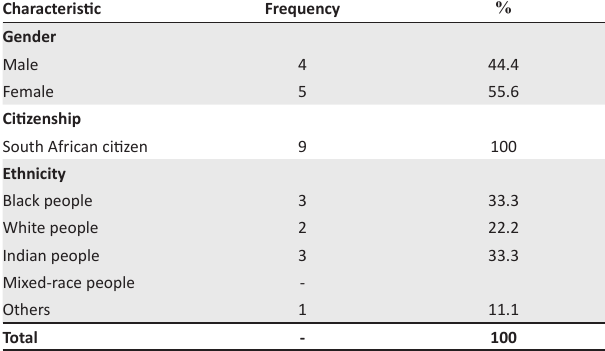
TABLE 2: Characteristics of participants (focus group; n = 9).